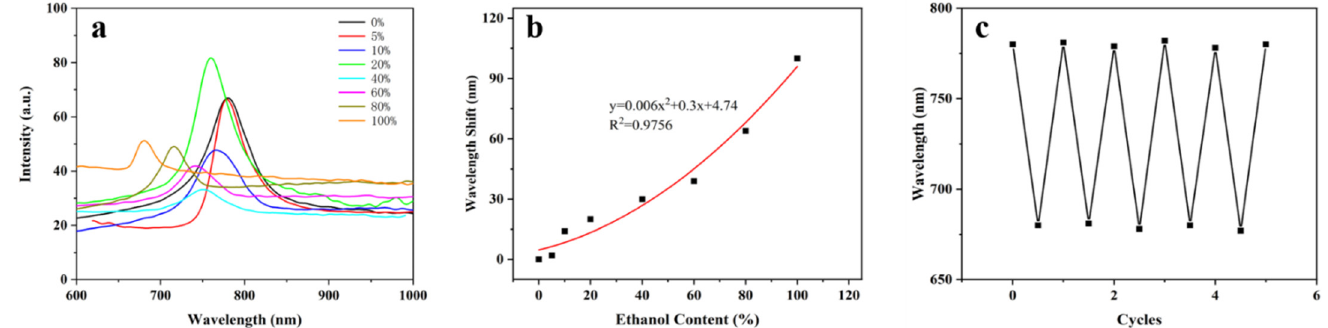
Figure 2. ( a ) Response of photonic crystal hydrogel to ethanol solution. ( b ) The relationship between redshift of reflection peak of the photonic crystal hydrogel and the concentration of ethanol. ( c ) Reproducible detection of photonic crystal hydrogels.